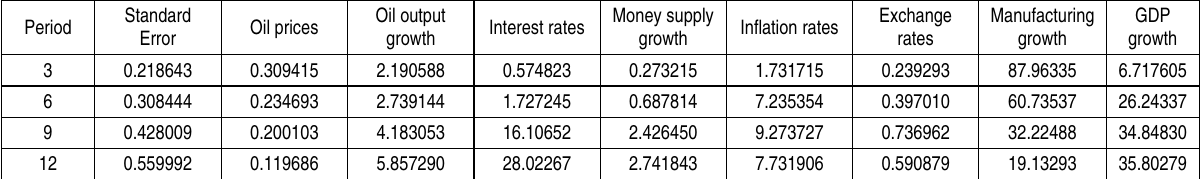
Table 5: Variance decomposition of manufacturing output